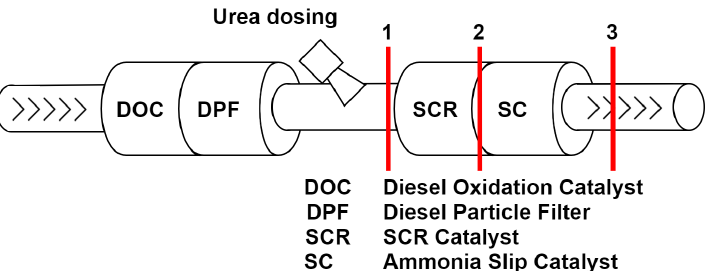
Figure 1. An exemplary arrangement of the exhaust aftertreatment system components of a diesel engine with SCR